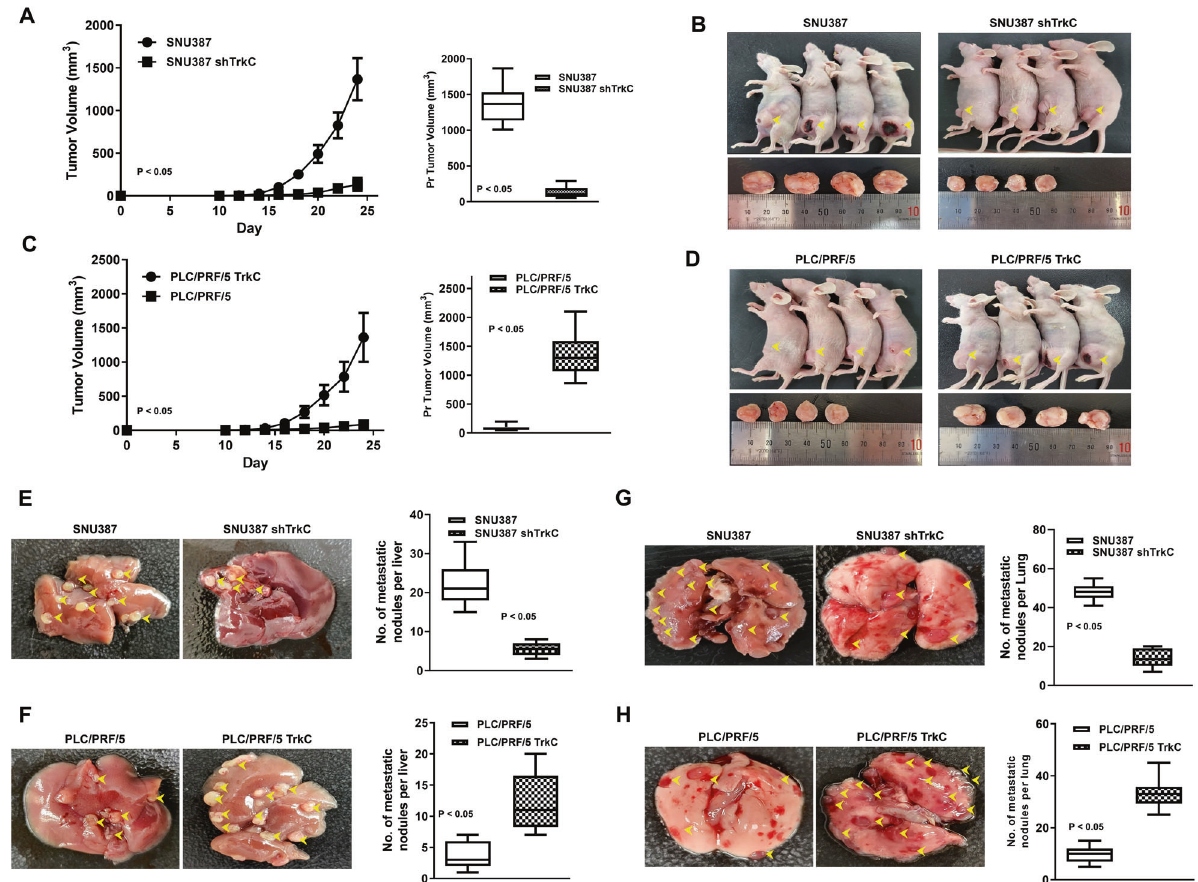
Fig. 3 Upregulation of TrkC increased tumor initiation and metastasis of HCC cells in vivo. In vivo tumor formation ( A ) and the representative images ( B ) of control SNU387 or TrkC knockdown cells in the mammary fat pads of mice. Each bar; mean ± SEM.; P < 0.05; t -test. n = 10 mice/group. In vivo tumor formation C and the representative images D of control PLC/PRF/5 or TrkC overexpression cells in the mammary glands of mice. The error bar, mean ± SEM; P < 0.05; t -test. n = 10 mice/group. E Quanti fi cation and representative images of liver surface metastatic foci of control SNU387 or TrkC knockdown cells. P < 0.05; t -test. n = 10 mice/group. ( F ) Quanti fi cation and representative images of liver surface metastatic foci of control PLC/PRF/5 or TrkC overexpression cells. P < 0.05; t -test. n = 10 mice/group. G Quanti fi cation and representative images of lung surface metastatic foci of control SNU387 or TrkC knockdown cells. P < 0.05; t -test. n = 10 mice/group. H Quanti fi cation (upper) and representative images (lower) of lung surface metastatic foci of control PLC/PRF/5 or TrkC overexpression cells. P < 0.05; t -test. n = 10